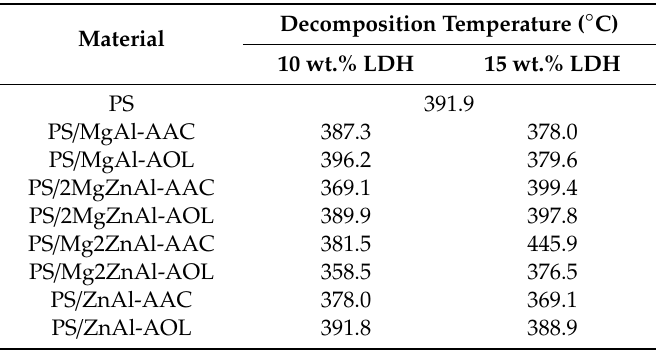
Table 5. Decomposition temperature of PS and